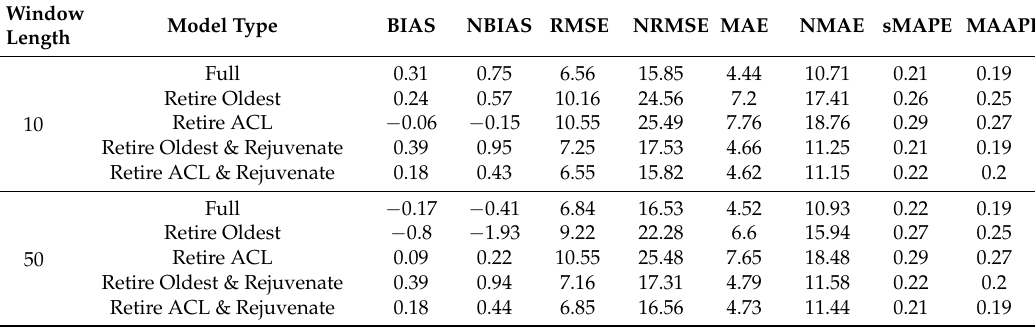
Table 3. One-hour ahead forecasting error evaluation for the different used types of DT with constant mean, for rolling windows of 10 and 50 days. BIAS, Root Mean Squared Error (RMSE) and Mean Absolute Error (MAE) are in the same units as the electricity price (c € /kWh); Normalized BIAS (NBIAS), Normalized RMSE (NRMSE), Normalized MAE (NMAE), Symmetric MAPE (sMAPE) and Mean Arc-tangent Absolute Percentage Error (MAAPE) are in